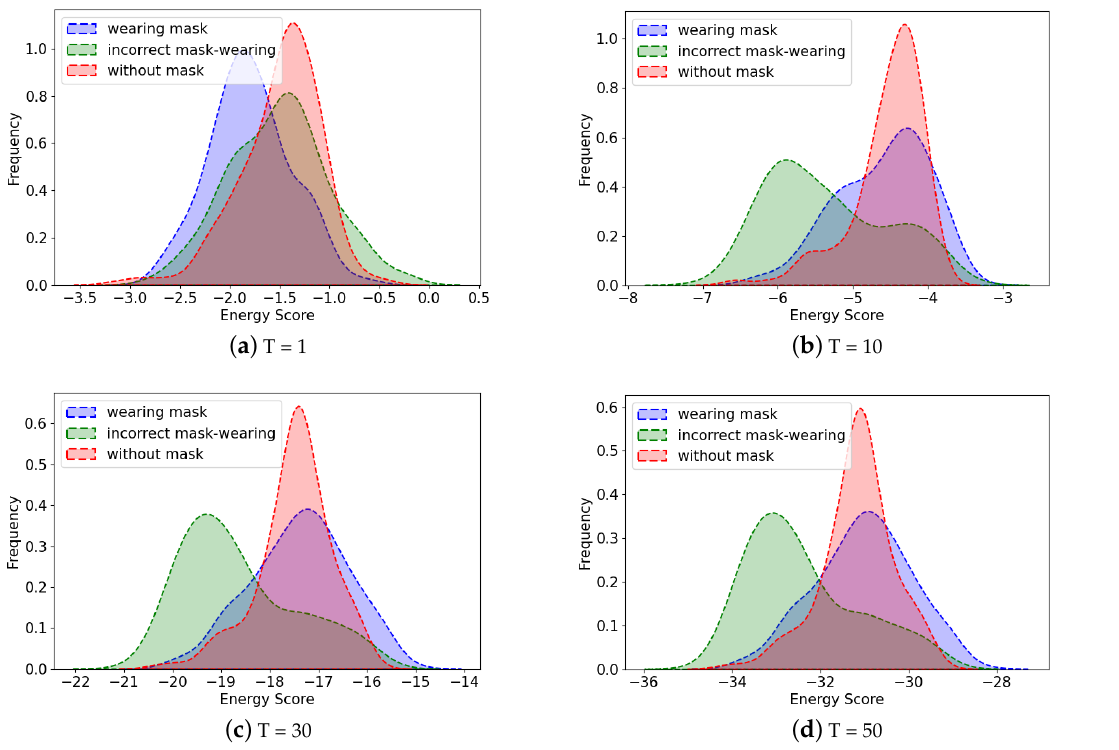
Figure 8. Class distributions corresponding to different T values: ( a ). When T equals 1, the overlap of three distributions makes it challenging to extract the incorrect mask-wearing class. ( b ). When T is set to 10, the peak of incorrect mask-wearing distribution can be clearly distinguished from other classes (wearing mask and without mask). ( c ). When T is set to 30, the distinction effect is further improved. ( d ). When the value of T is greater than or equal to 30, the distribution of the three classes changes little. The energy scores increase with the value of T, but the range of score still remains within